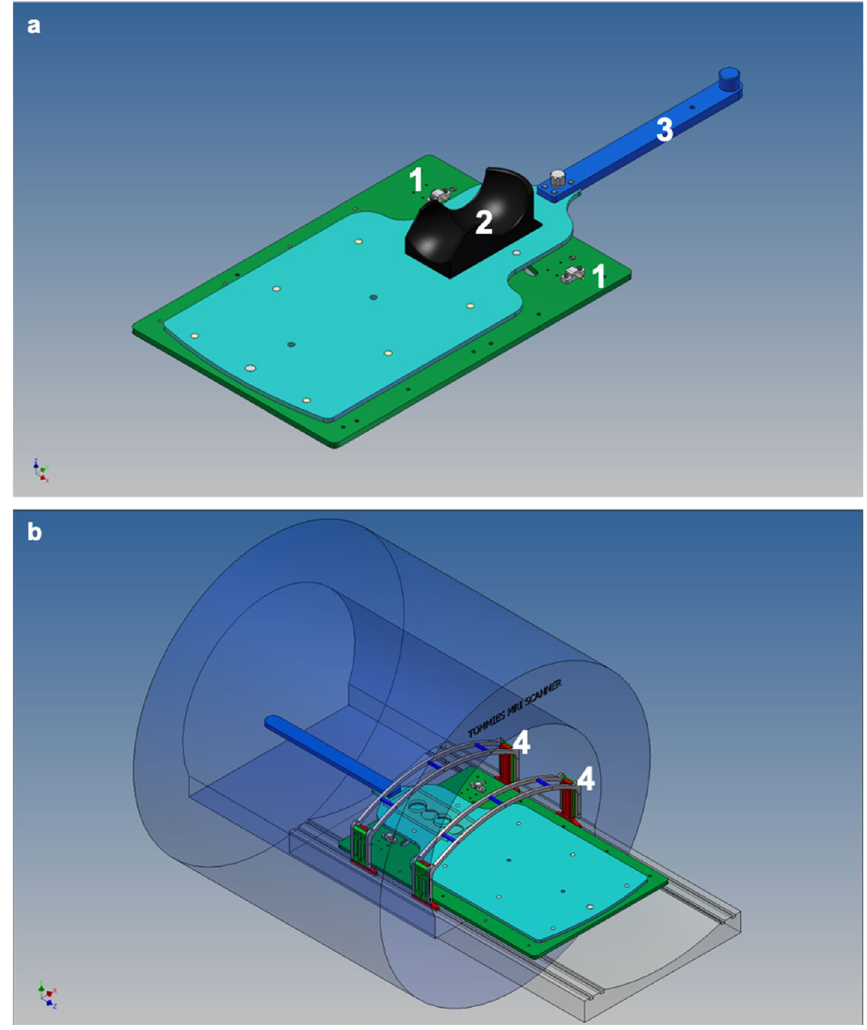
Figure 1. a (top) and b (bottom) Construction design of the motion device. ( a ) Detailed overview of the main components of the device: flat upper plate (light blue), which is mobile and moves the volunteer who is placed on it. Lower sub-plate (green), which is stationary fixed on the patient table. Integrated mechanical stops limiting the translational range of motion (1). Headrest to immobilize the neck of the volunteer (2). Elongated handle to perform the motion of the upper plate (3) while a rail is guiding the movement of the upper plate on the lower plate. Central pin connecting the upper and lower plate and representing the centre of rotation. ( b ) Fitting of the motion device into an Ingenia MRI-scanner. Coil bridges simulating the belly top of a pregnant woman and ensuring that the anterior body coil stays stationary and contact free above the moving volunteer below